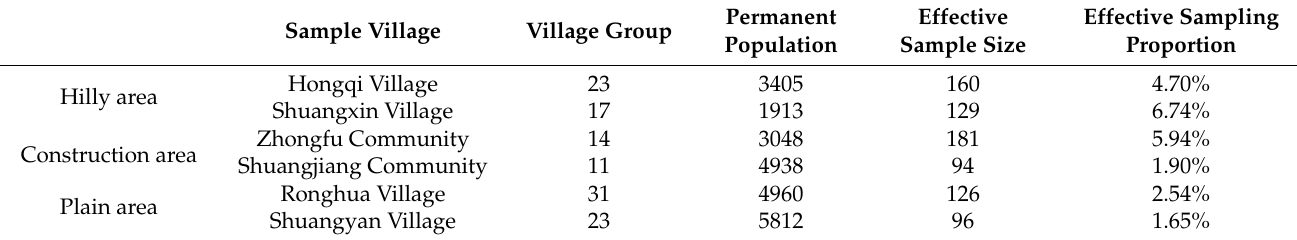
Table 2. Percentage of